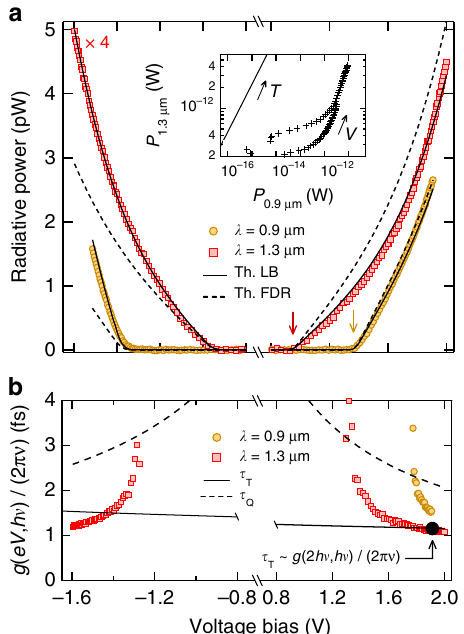
Fig. 5 Measurements at optical frequencies. a Radiated power as a function of bias voltage V in the con fi guration depicted in Fig. 3. Markers correspond to data recorded at different wavelengths. Data at λ = 1.3 μ m (red squares) have been multiplied by a factor 4 for clarity. Vertical arrows de fi ne the voltage cut-off eV = hc / λ . Solid lines and dashed lines are theoretical expectations from Eqs. (1) and (5) respectively. Horizontal axis has been split for clarity. Inset: Relationship between the light power at two different wavelengths with increasing bias voltage. Solid line corresponds to the black-body law with increasing temperature. b Experimental data of g ( eV , h ν )/(2 πν ) recorded at different wavelengths (markers). The dashed lines correspond to the correlation time τ Q whereas the solid line reads for the 1D traversal time at Fermi energy τ T ( eV , h ν ). Assuming that τ T is rather ; ϵ constant in the energy range ½ ϵ h ν (cid:2) we are interested in the measured F F þ g ð 2 h ν ; h ν Þ value of the 1D traversal time at ϵ (cid:6) h ν given by the black dot τ T (cid:6) 2 ν (Methods)